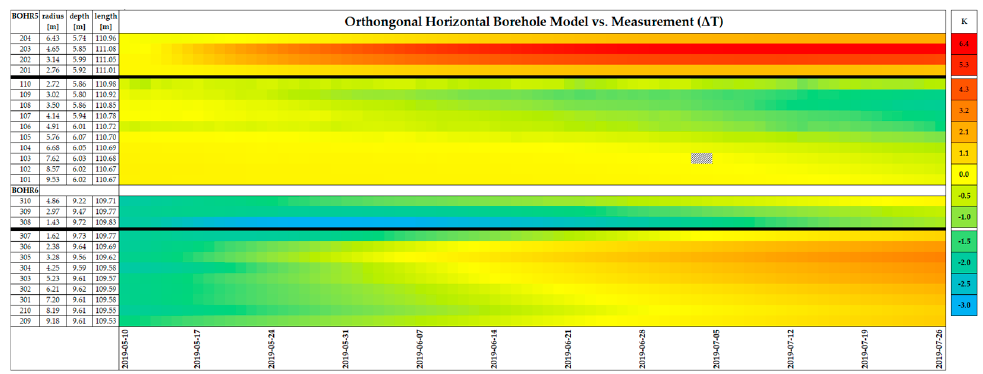
Figure 27. BOHR5 and BOHR6 modeled temperatures plotted against measured temperatures.